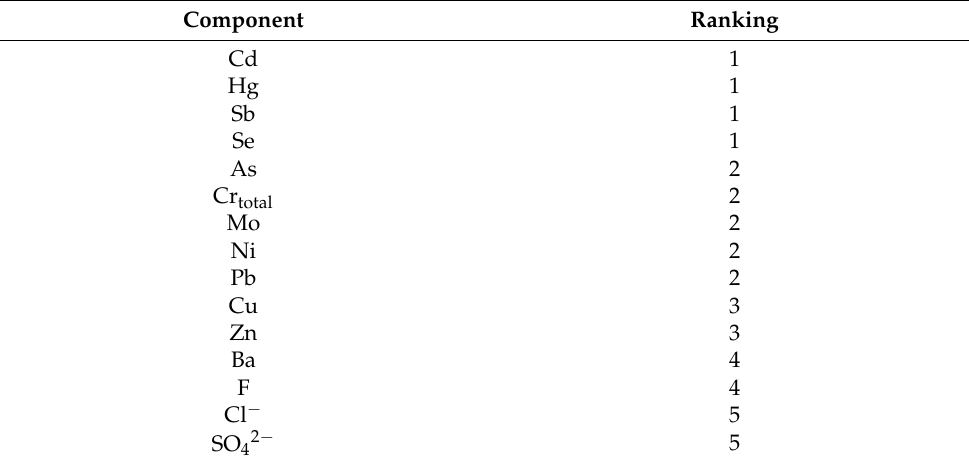
Table 4. Components and their ranking applied in this study.